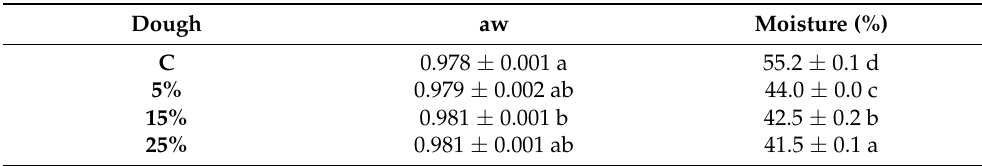
Table 3. Water activity (aw) and moisture content of dough: wheat flour (control: C) and blends of wheat flour and oat flour at levels of 5, 15, and